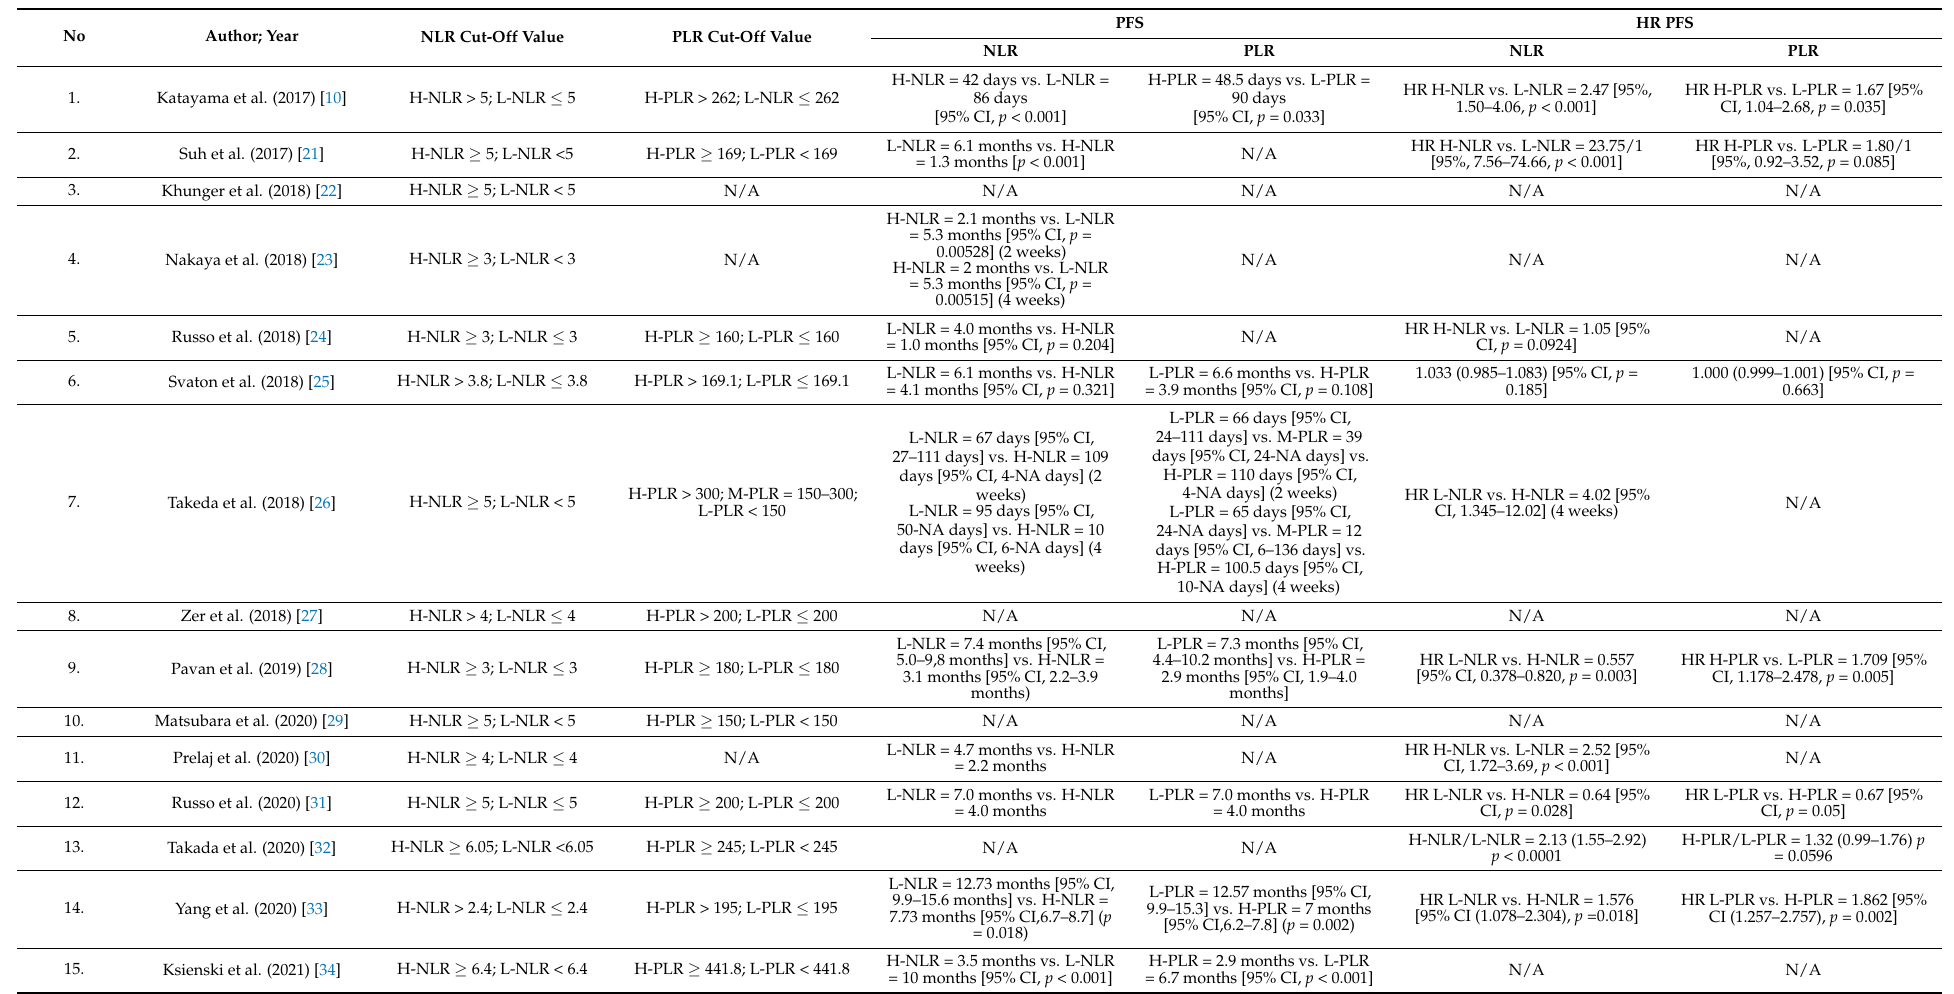
Table 2. Outcomes of included studies (progression-free